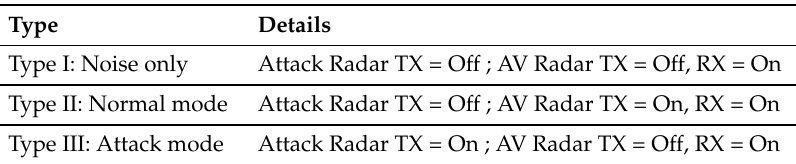
Table 3. List measurement